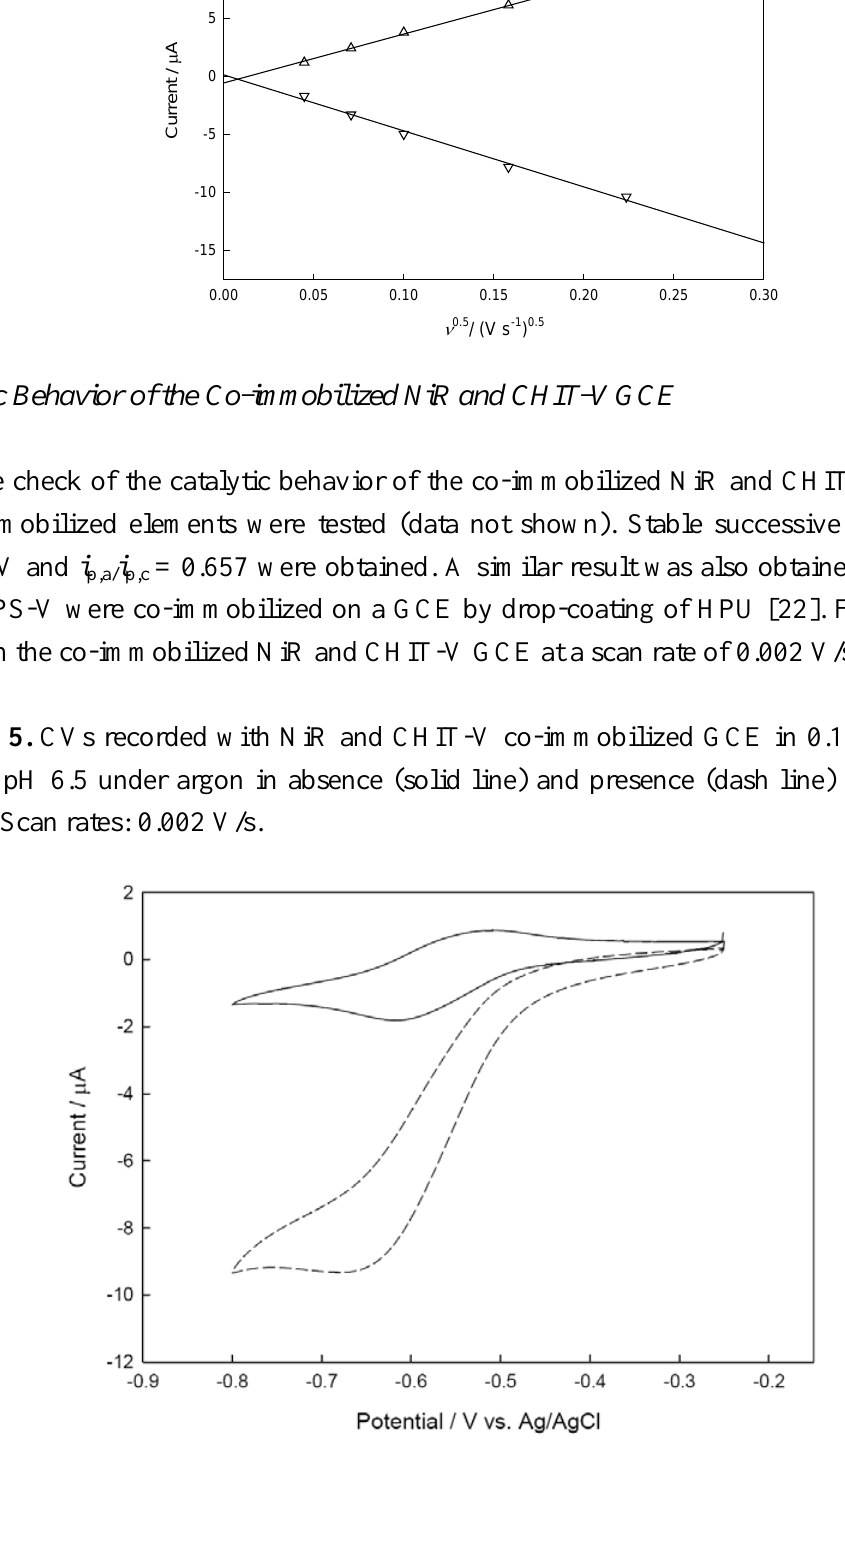
Figure 4. i – ν profile of CHIT-V immobilized GCE (triangle down: i p